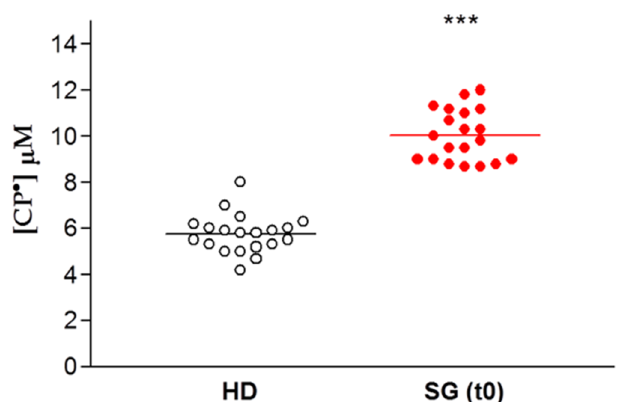
Figure 3. EPR- spin probing analysis of oxidative stress in blood. Healthy Donors (HD) vs.